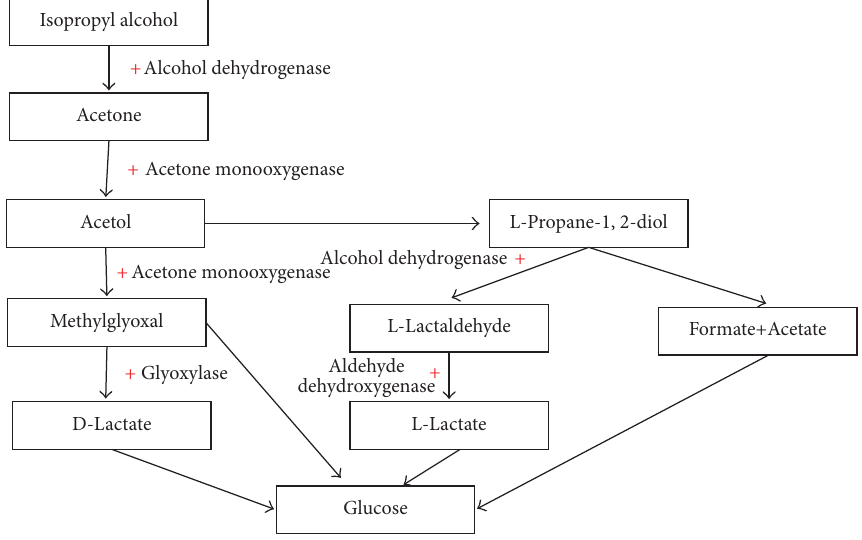
Figure 2: An overview of in vivo isopropyl alcohol